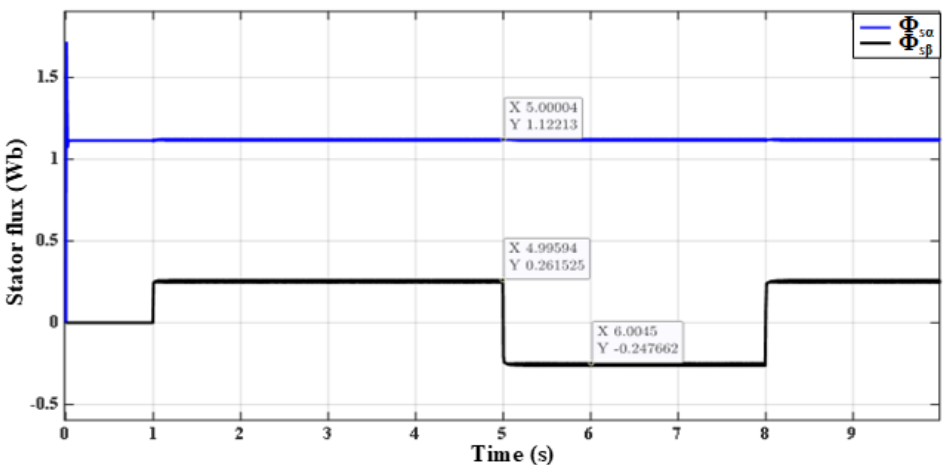
Figure 19. The testbed behaviour of the FOC algorithm stator flux vector components